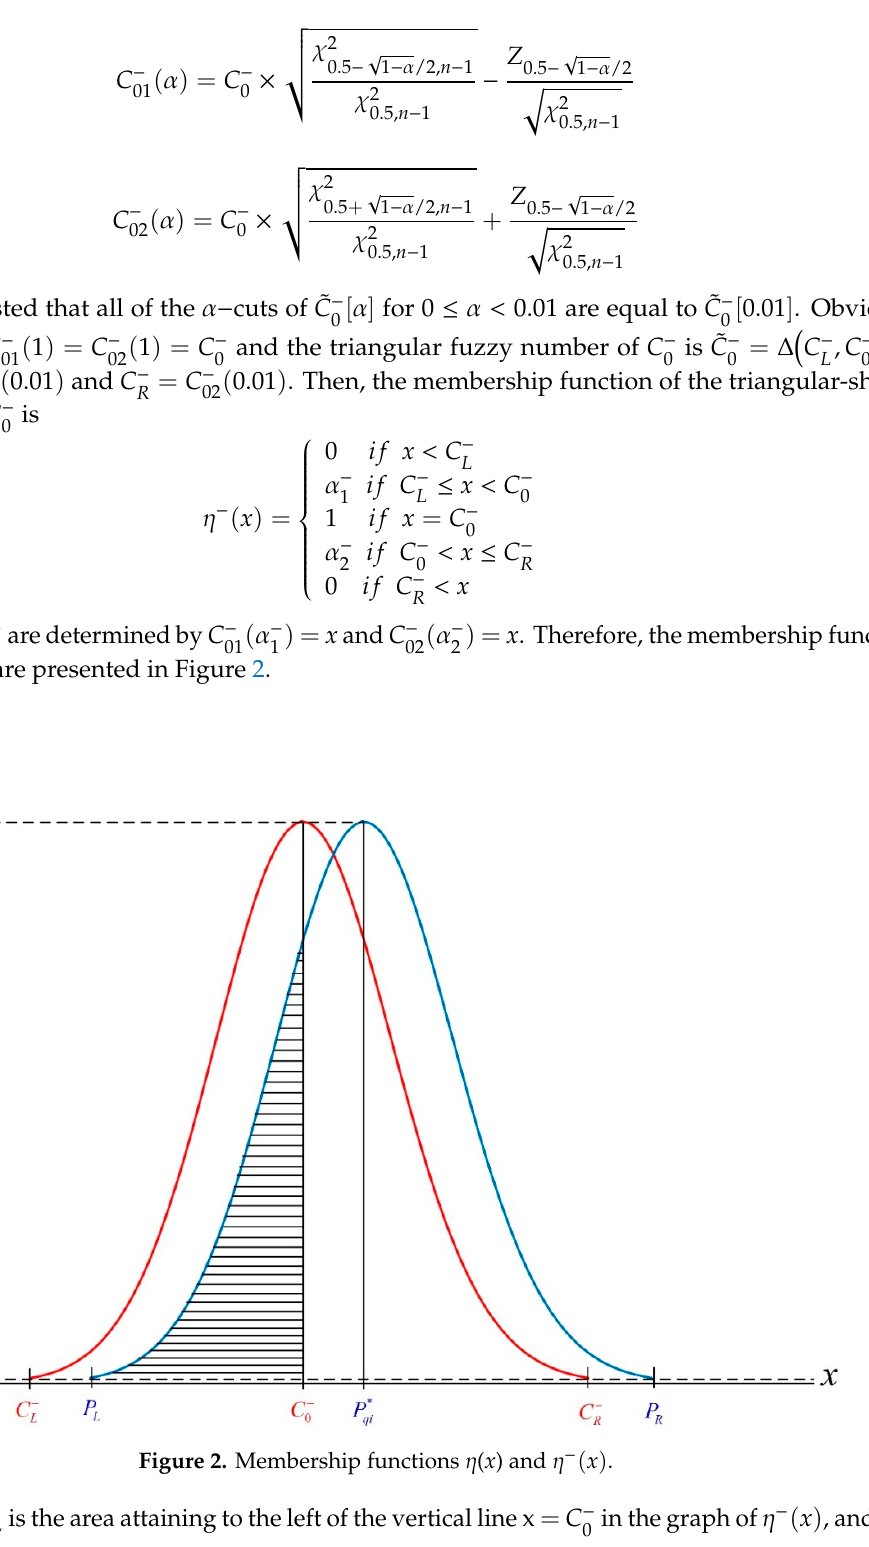
Figure 2. Membership functions η ( x ) and η